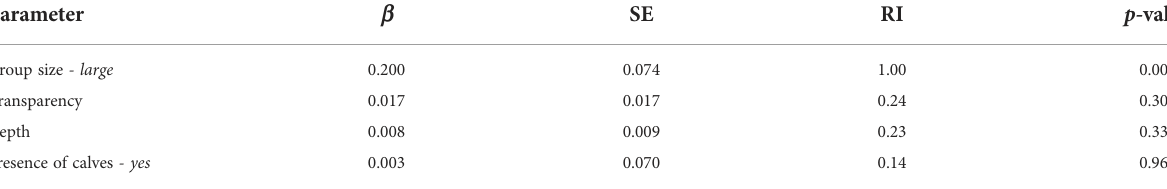
TABLE 8 Model-averaged predictor coef fi cients and relative importance (RI).